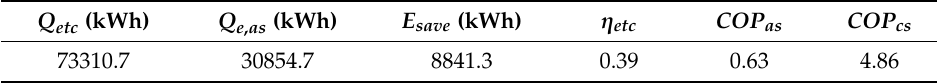
Table 5. Annual performance of SASCHCS in the optimal